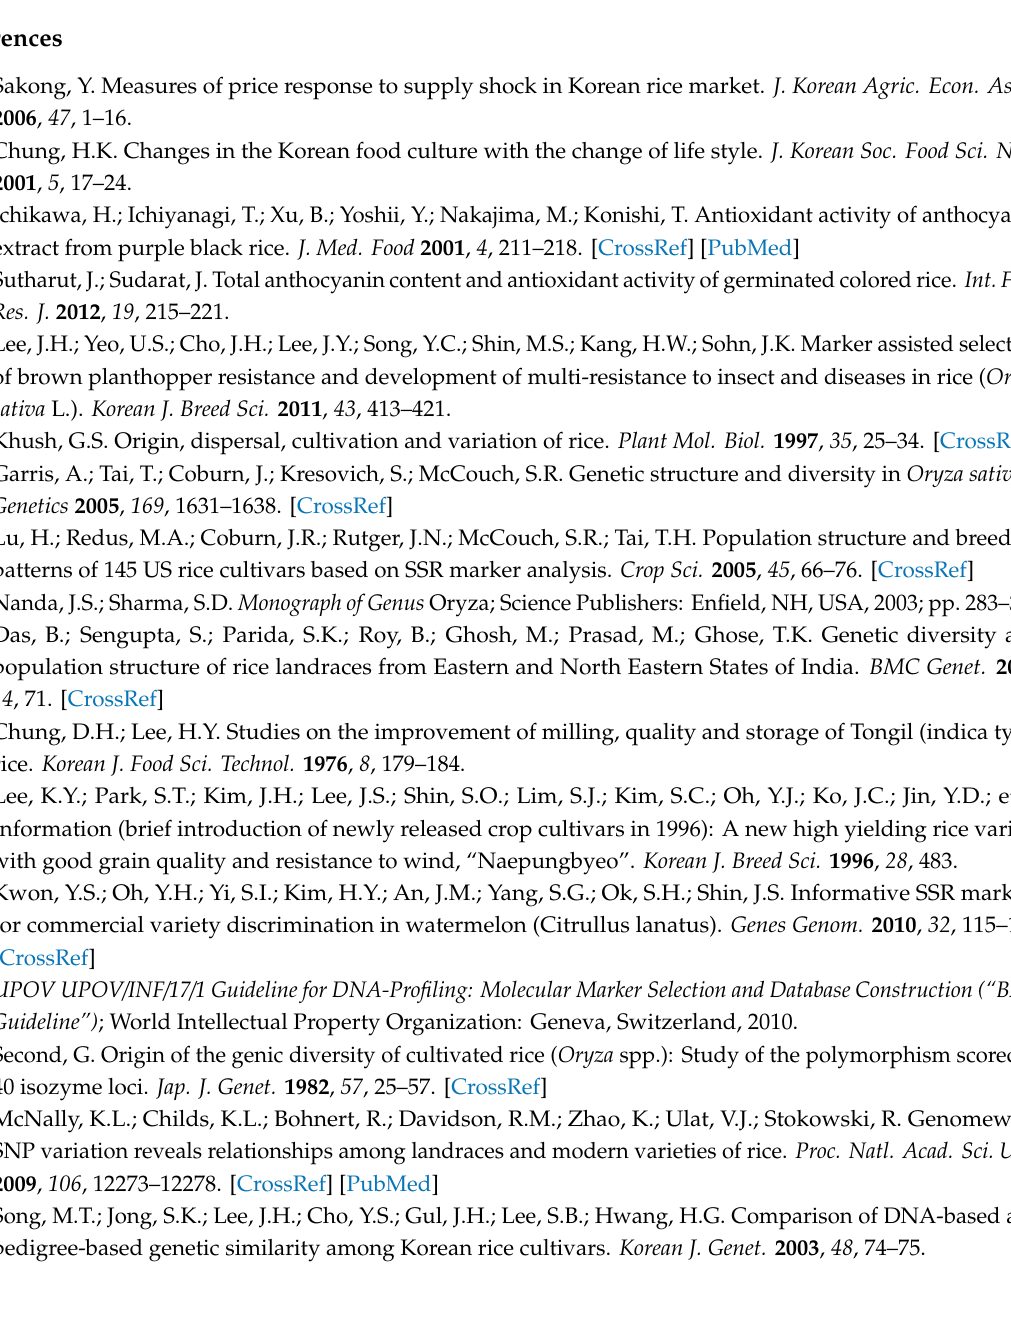
Figure S1: Dendrogram of 548 rice varieties based on 16 SSR markers. The scale at the bottom is Jaccard’s coe ffi cient of similarity. Table S1: List of rice cultivars and germplasms assayed for genetic characterization using microsatellite